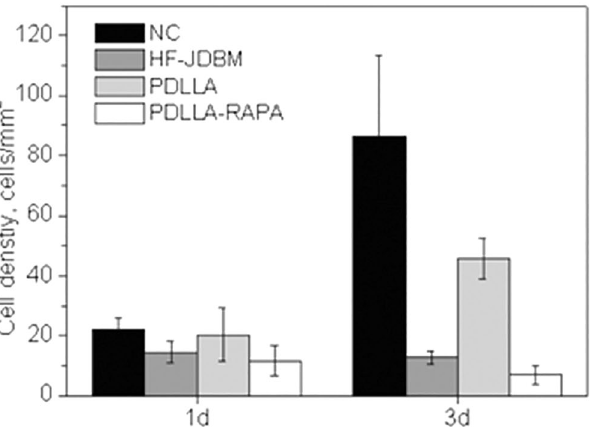
Figure 2. Statistics of A7r5 cell densities on various samples (Five fields are counted for each group and the results are presented as mean ± SD).